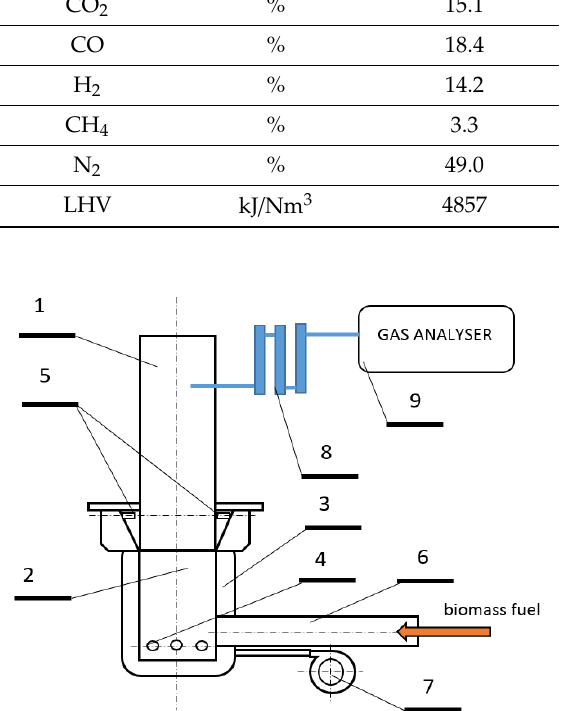
Figure 3. Gasification of biomass fuel in the retort burner: (1)—syngas chamber, (2)—gasification furnace, (3)—air chamber, (4)—gasification air inlets, (5)—combustion air inlets, (6)—screw feeder, (7)—air blower, (8)—syngas purification battery, (9) measurement of syngas composition—GAS 3000 syngas analyser. Table 2. Syngas components from biomass.